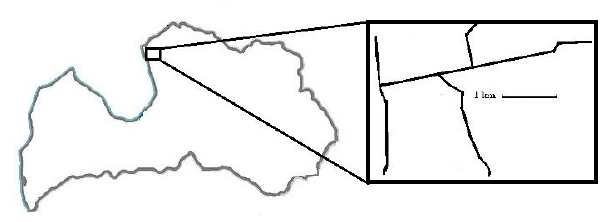
Fig. 1. Latvia. Forest road network in Salacgriva district. Forest road density is relatively low, thus preventing the accommodation of appropriate control lines in the survey area.